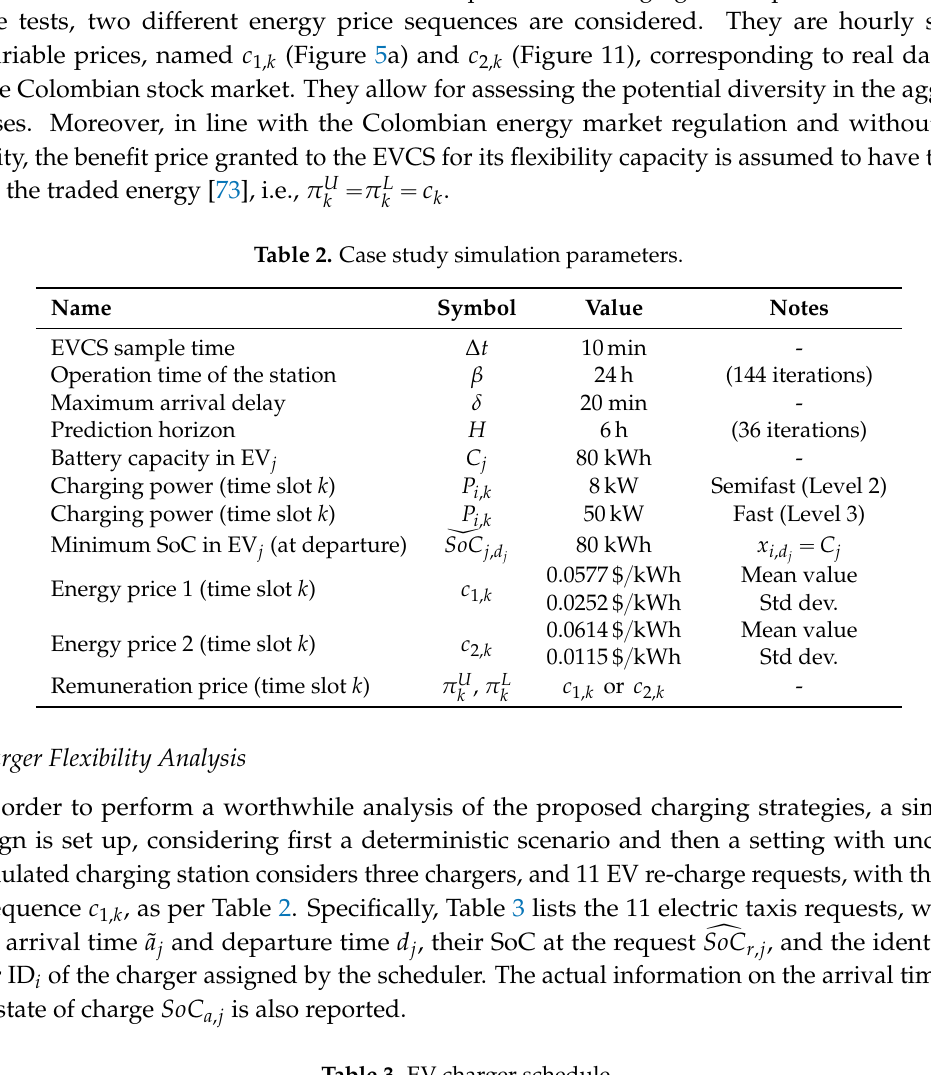
Table 3. EV charger